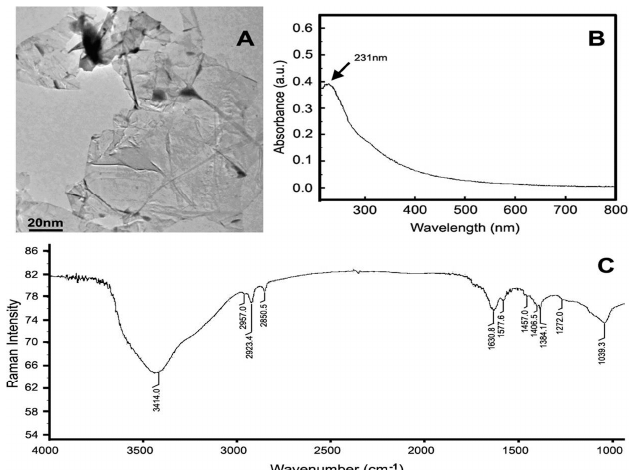
Figure 1. Characterization of graphene oxide (GO). ( A ) Transmission electron microscope (TEM) shows GOs 100–500 nm; ( B ) ultraviolet (UV) scanning shows GO absorption peak at 231 nm; ( C ) Fourier transform infrared spectroscopy FTIR analysis suggests obvious characteristic peaks: 3414 cm − 1 , 1630 cm − 1 , 1040 cm − 1 , and 1577 cm − 1 .